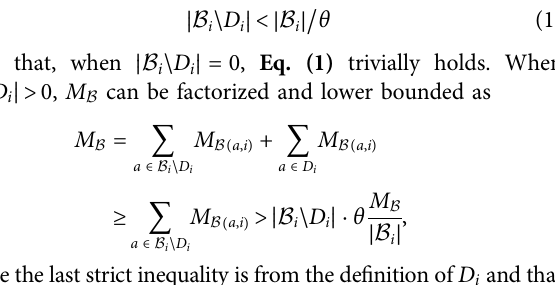
TABLE 3 | Summary of real-world datasets.